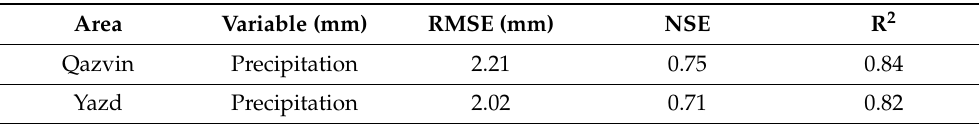
Table 5. Statistical measures of observed and downscaled mean monthly precipitation during validation period from 2011 to 2012.